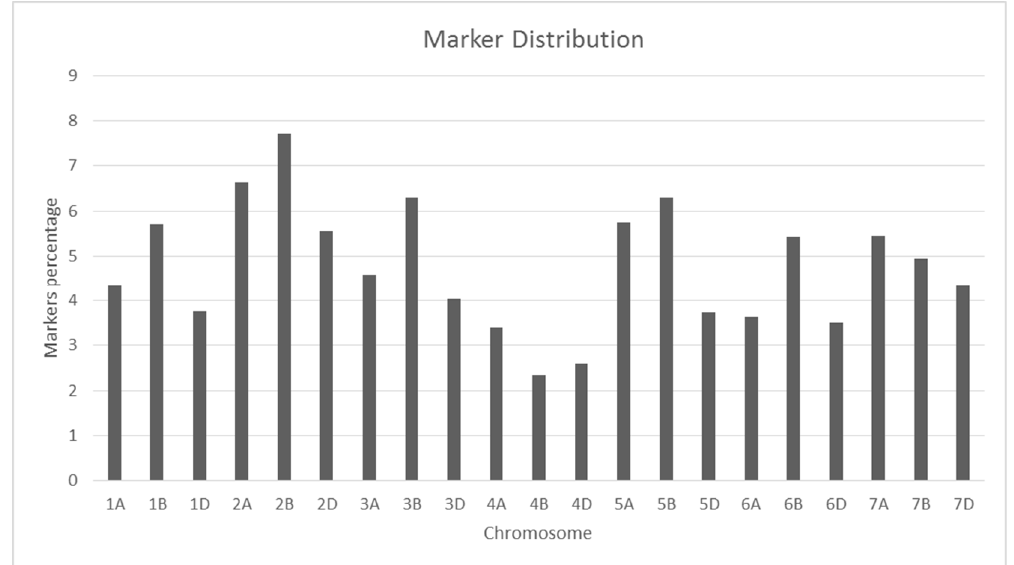
Figure 2. Percentage of markers used in the study on 21 chromosomes of wheat.